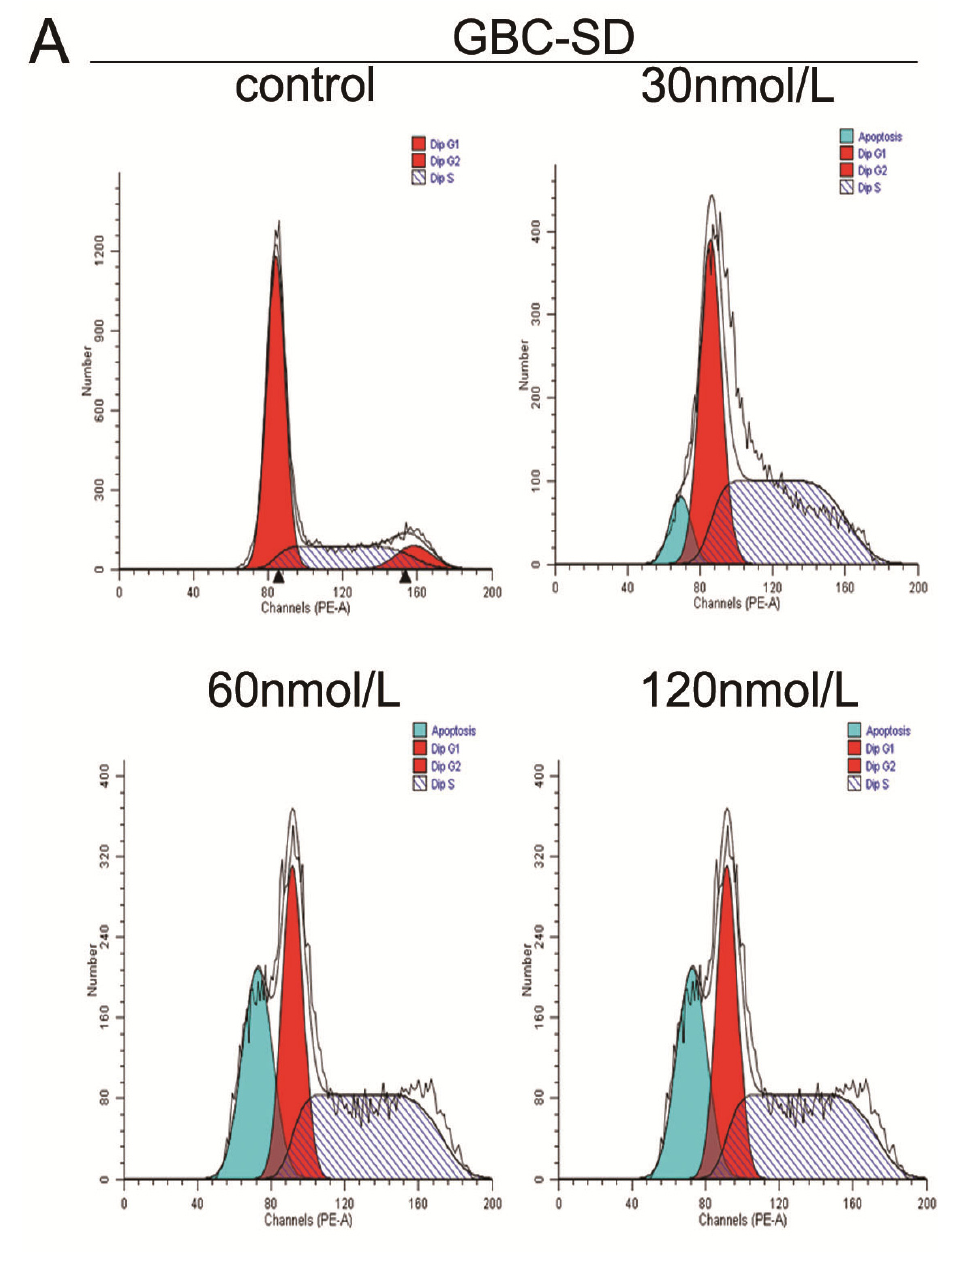
Figure 3. Effect of triptolide on cell cycle distribution in gallbladder cancer cells. ( A) and ( B) , GBC-SD and SGC-996 cells were treated with various concentrations of triptolide for 48 h, the DNA content was analyzed by flow cytometry. (C) and ( D) , The percentage of cells in the G0/G1, S, and G2/M phases of the cell cycle were calculated. Results are expressed as mean ± SD from three independent experiments. ( E) and ( F) , Effects of triptolide on the protein levels of Cyclin A, CDK2, p21 and p27 in GBC and SGC-996 cells. After incubation with varying concentrations of triptolide for 48 h, whole cell lysates were prepared and western blot analysis was performed using anti-Cyclin A, anti-CDK2, anti-p21 and anti-p27 antibodies, with β -actin serving as a loading